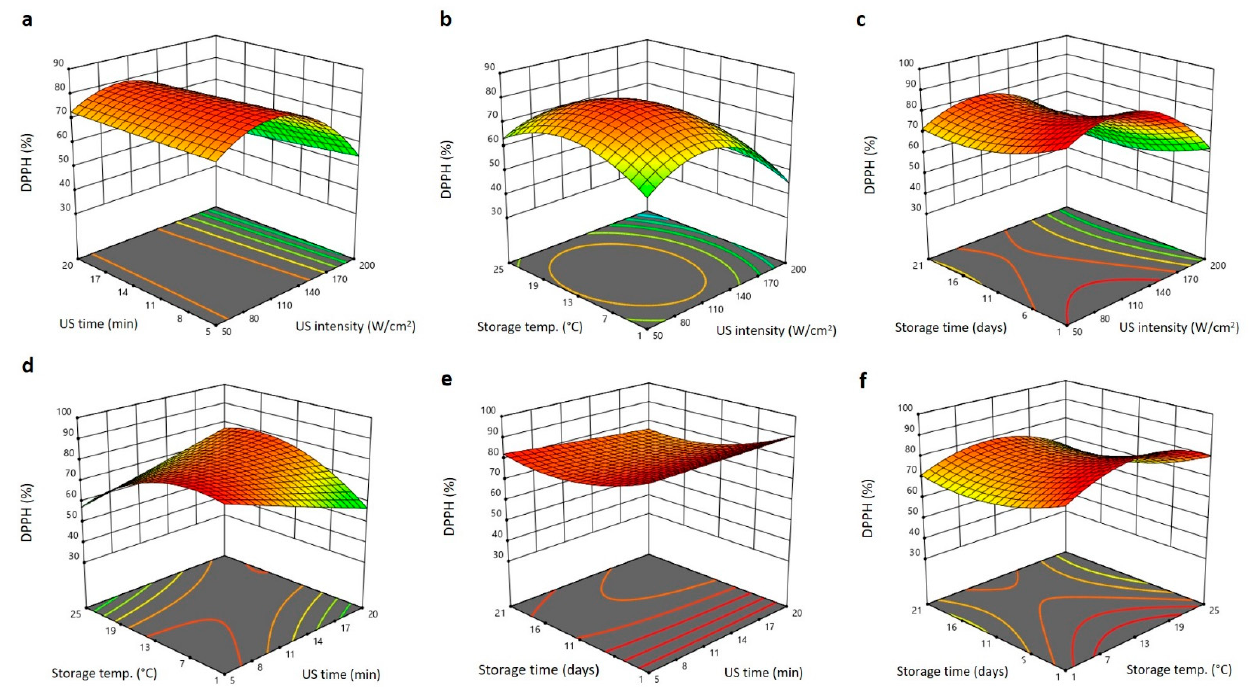
Figure 7. Response surface plots of DPPH antiradical activity of Barhi dates as a function of US time and US intensity ( a ), storage temperature and US intensity ( b ), storage time and US intensity ( c ), storage temperature and US time ( d ), storage time and US time ( e ), and storage time and storage temperature ( f